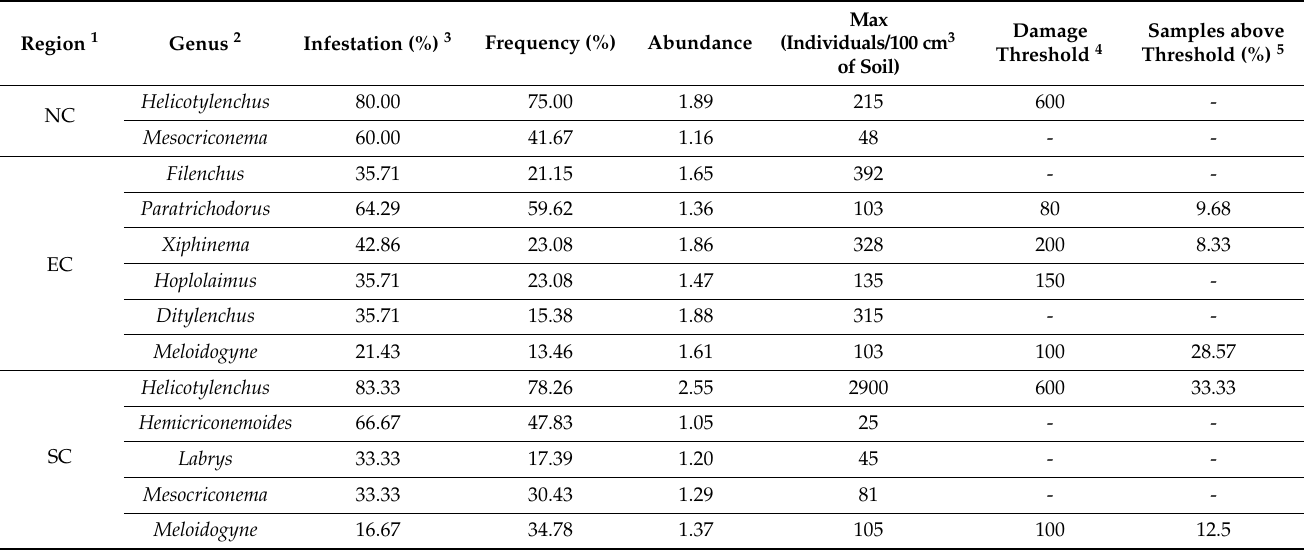
Table 3. The infestation, frequency, abundance, and damage threshold of the main nematode genera in golf